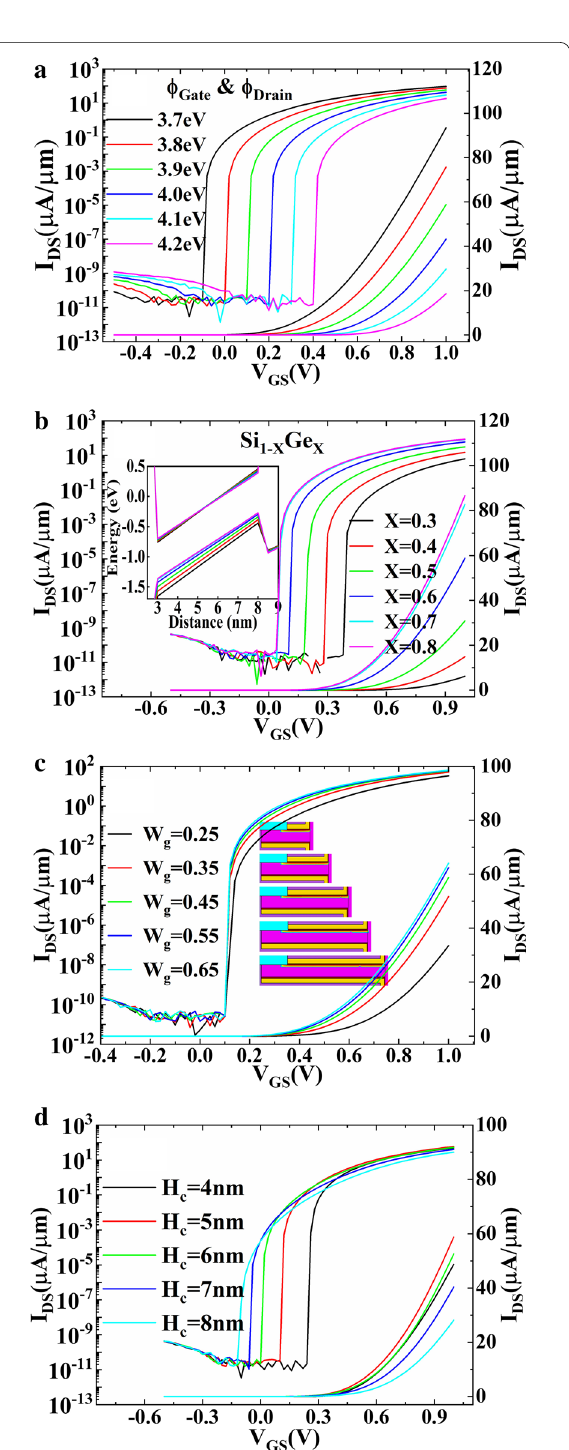
Fig. 6 Transfer characteristics with different a gate work function ( φ Gate ) and drain work function ( φ Drain ), b SiGe composition ratio, c gate length ( W g ) and d channel thickness ( H c